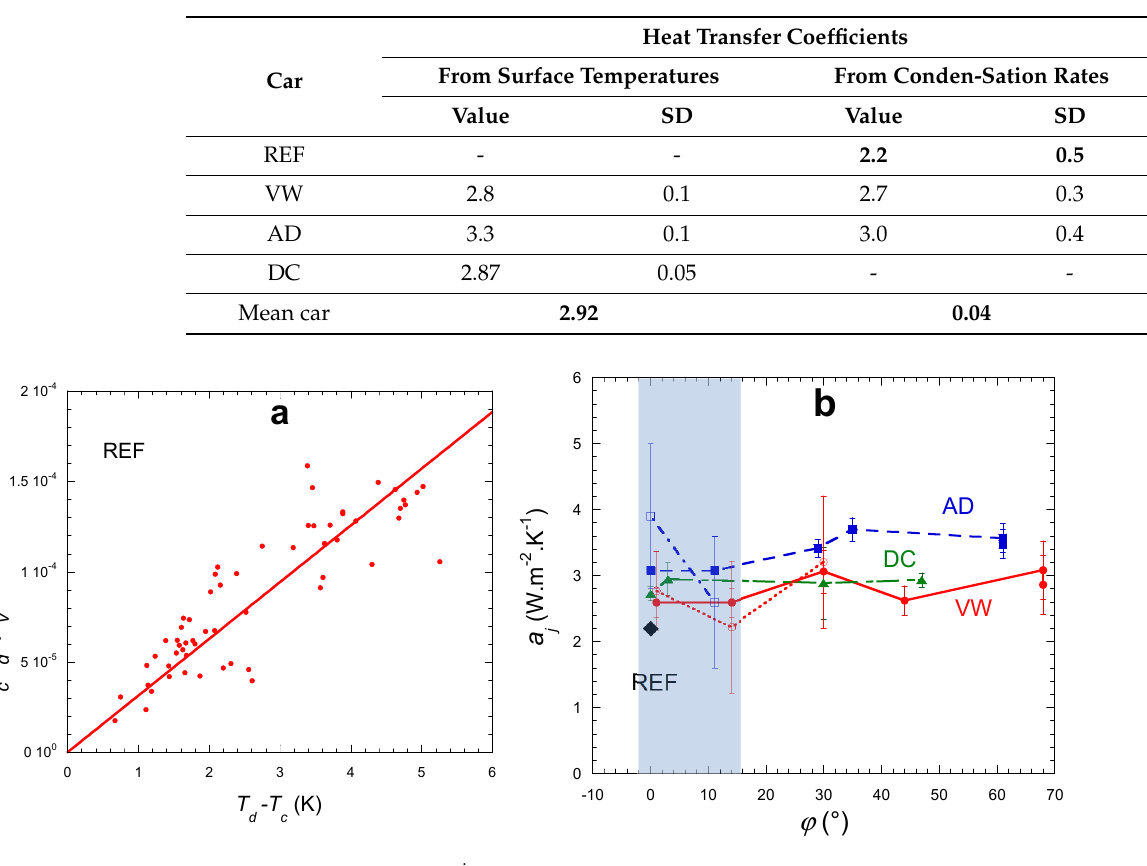
Table 6. Mean values of heat transfer coefficients from surface temperature using the value a REF (bold) = 2.2 W · m − 2 · K − 1 in Table 5, and from condensation rates using Equation (38). The mean values are highlighted in bold.